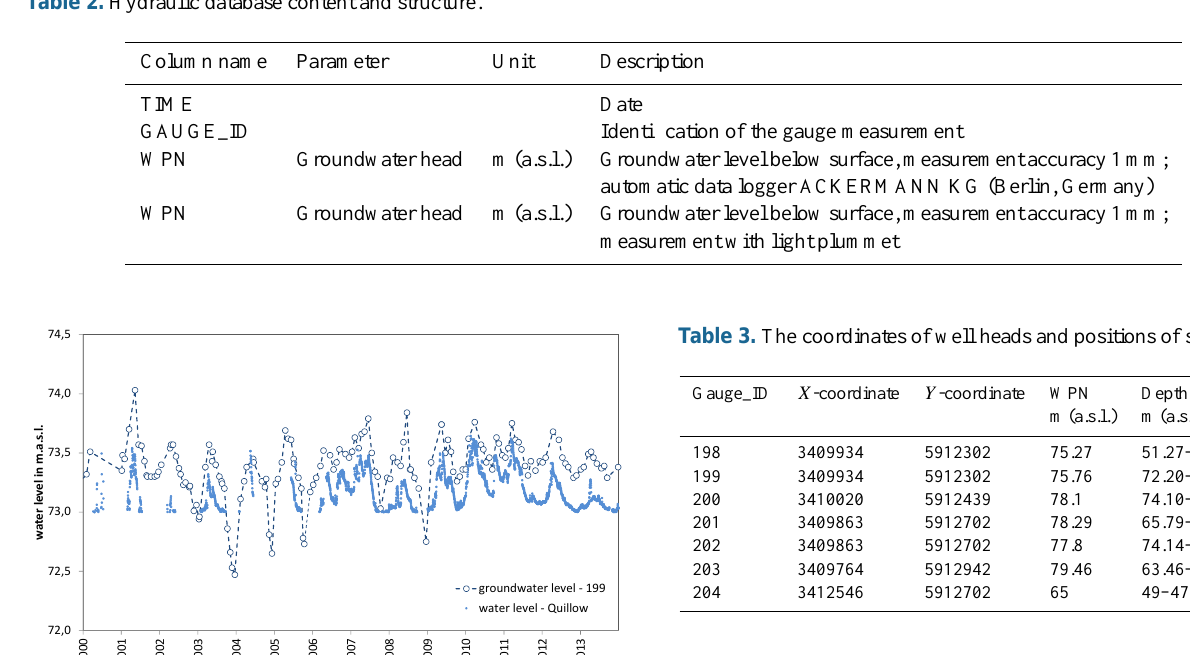
Table 2. Hydraulic database content and structure.